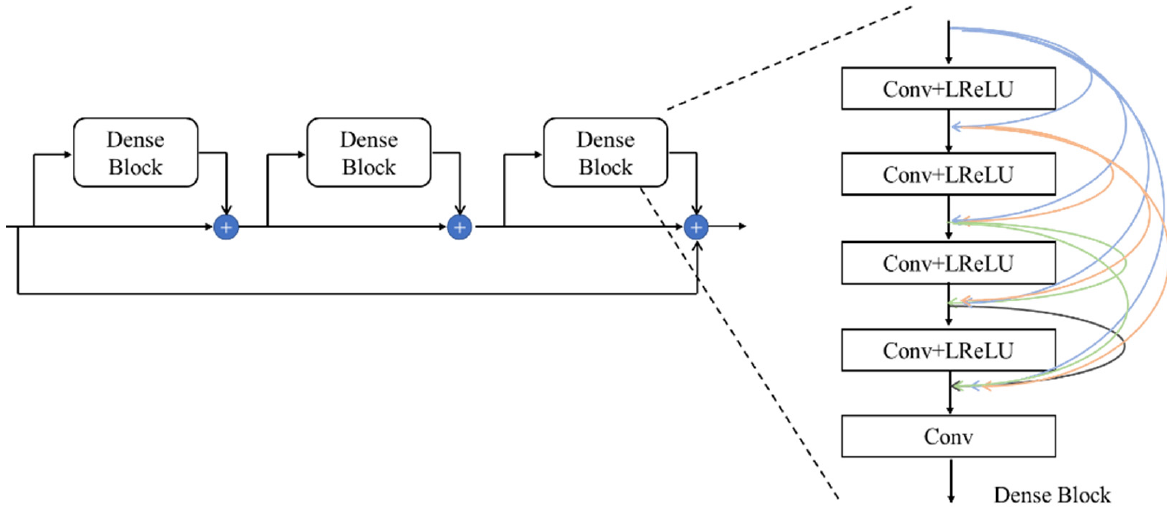
Figure 12. RRDB network structure.